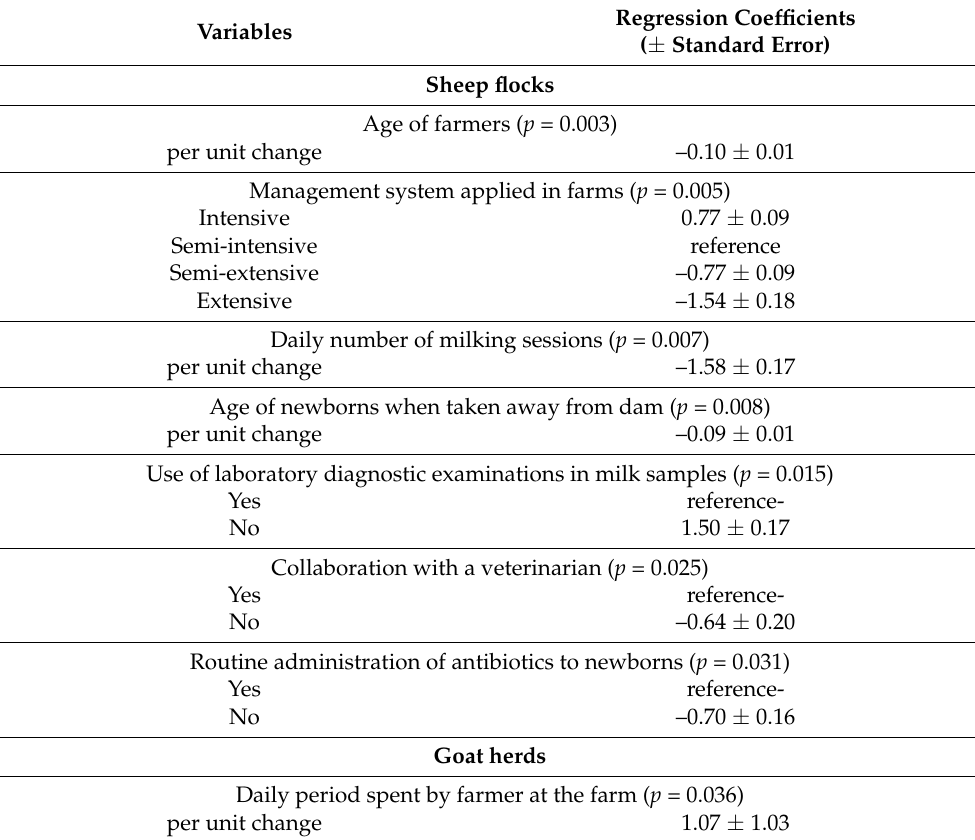
Table 5. Detailed results of multivariable analyses for associations with total number of optional vaccinations performed in 325 sheep flocks and 119 goat herds in Greece.